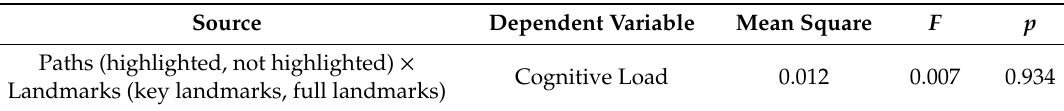
Table 3. Results of cognitive-load interaction